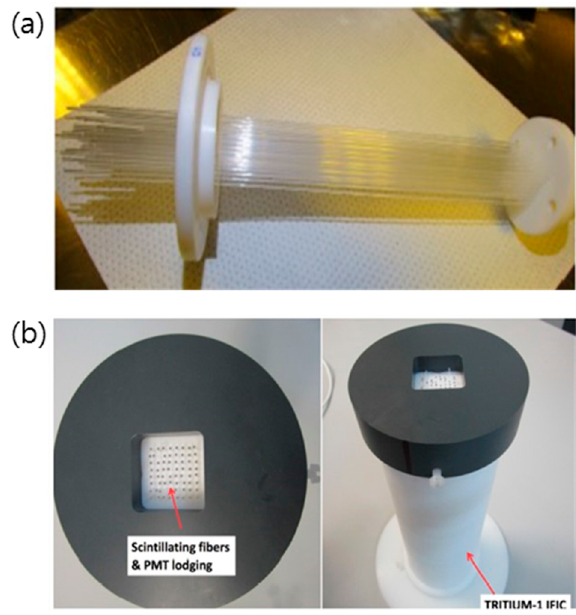
Figure 22. Tritium-1, IFIC proto-type detector: ( a ) bundle of the optical fibers, ( b ) PTFT container [90].